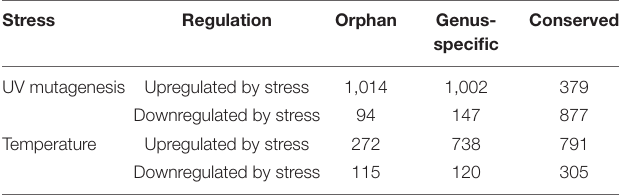
TABLE 2 | Numbers of genes/ORFs regulated by UV mutagenesis and temperature stresses.